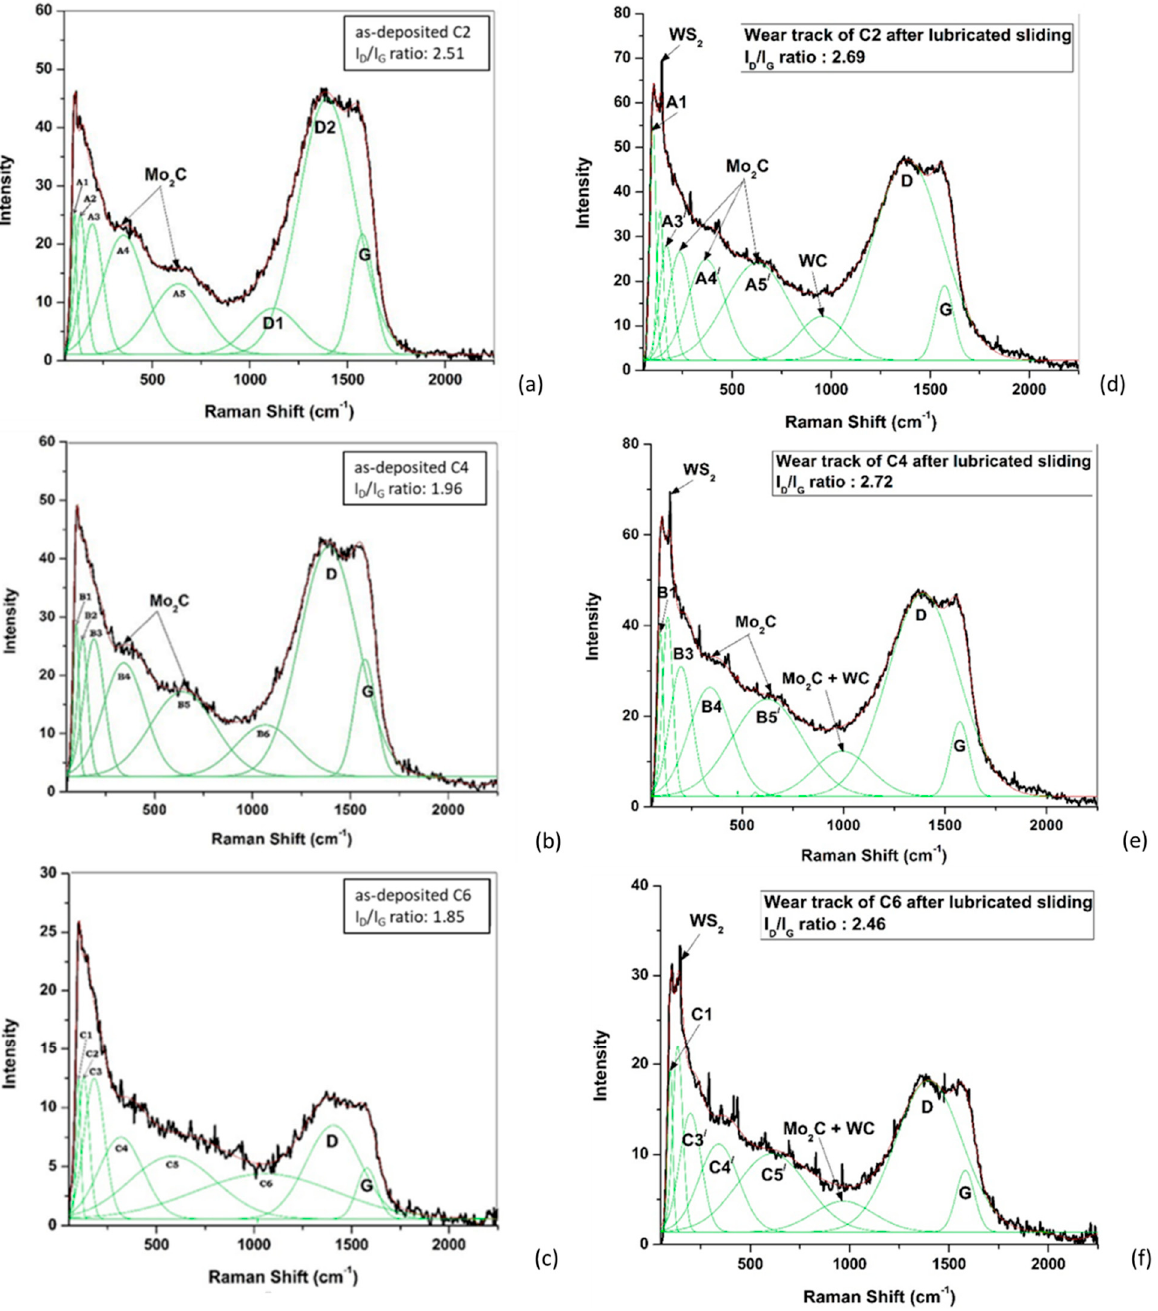
Figure 7. Raman spectra collected from C2, C4 and C6 ( a – c ) in as-deposited condition and ( d – f ) within the wear tracks after lubricated sliding at ambient temperature.